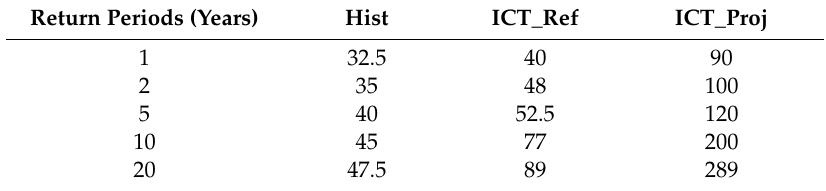
Table 4. Annual daily precipitation (mm) for different return periods in the Mono river basin. Return Periods (years)